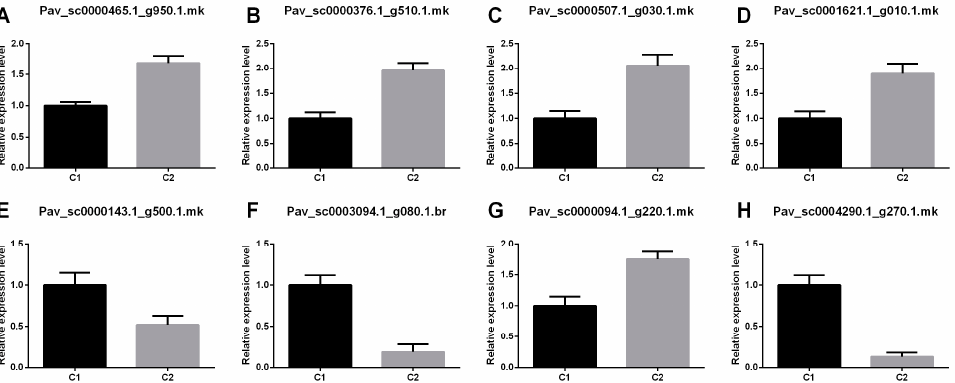
Figure 6. The qRT-PCR validation for 8 TFs. ( A ) Pav_sc0000465.1-g950.1.mk; ( B ) Pav_sc0000376.1-g510.1.mk; ( C ) Pav_sc0000507.1-g030.1.mk; ( D ) Pav_sc0001621.1-g010.1.mk; ( E ) Pav_sc0000143.1-g500.1.mk; ( F ) Pav_sc0003094.1-g080.1.mk; ( G ) Pav_sc0000094.1-g220.1.mk; ( H ) Pav_sc0004290.1-g270.1.mk. The histogram bars represent the means ± SE. All the data were calculated with three technical replicates, and the statistical significance was set at p < 0.05.